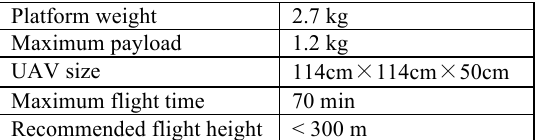
Fig.1 External view of md4-1000 Table 1. Main characteristics of md4-1000 Platform weight Table 1. Main characteristics of md4-1000 Platform weight